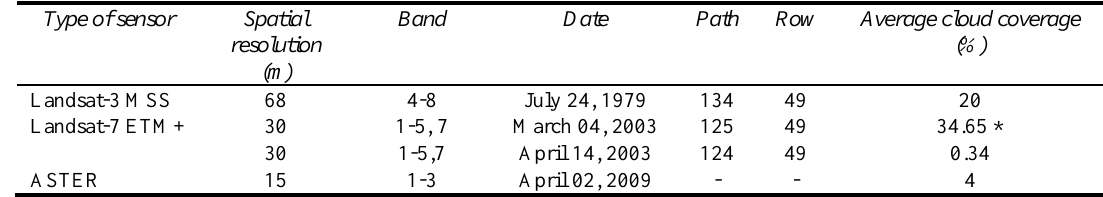
Table 1. Characteristics of satellite data used in study area